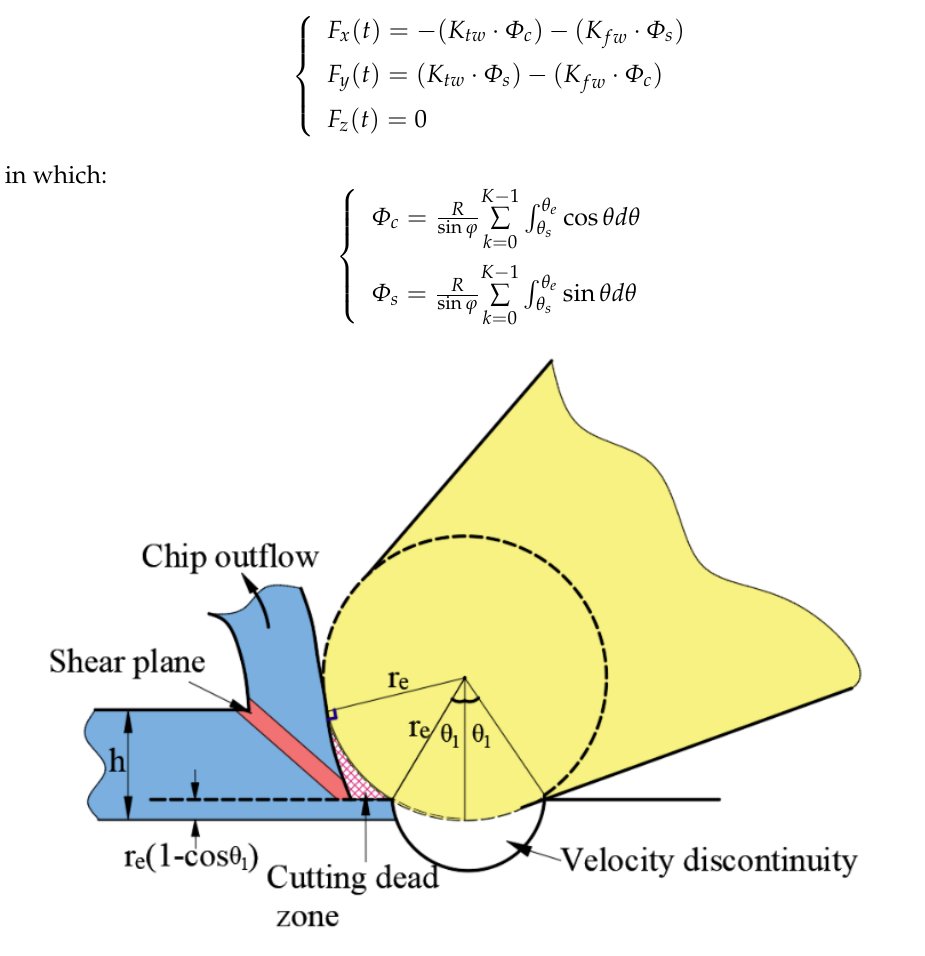
Figure 19. The interaction between the metal dead zone and the arc radius of the cutting edge.